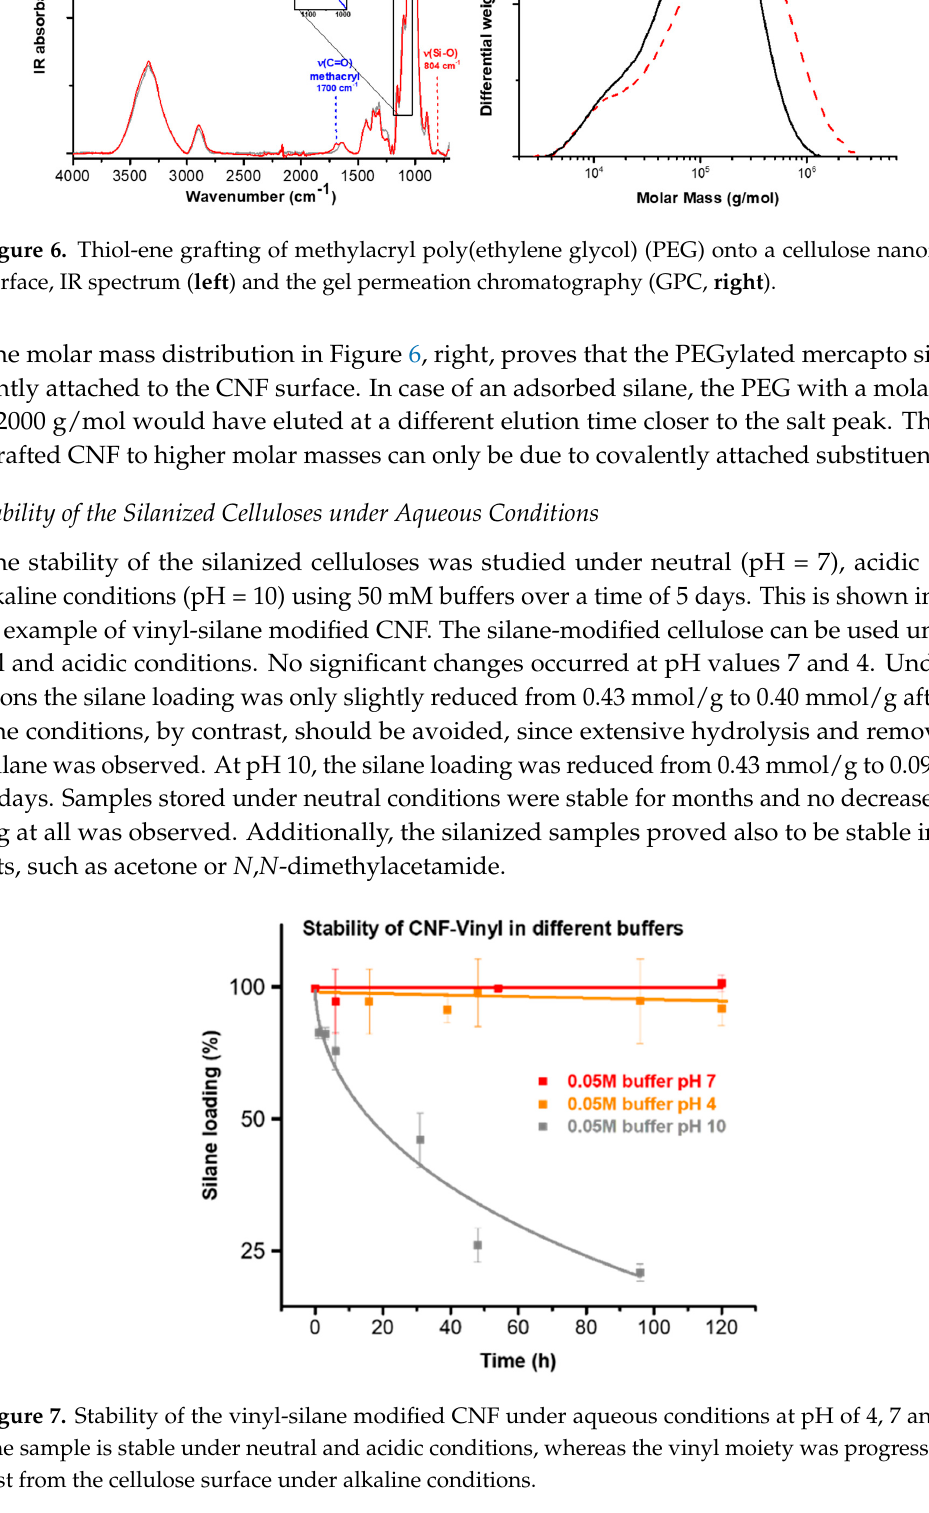
Molecules 2018 , 23 , x FOR PEER REVIEW 8 of 16 Figure 5. ( A ) Comparison of silanization kinetics of cellulose II gel with 3-azidopropyl triethoxysilane between novel approach and conventional literature procedure [6]. The kinetics of the two-step procedure (hydrolysis and condensation) have a linear fit (zero-order) instead of the previous sigmoidal fit. ( B ) Kinetics of the different silanization agents used in this work (substrate cellulose II gel), with the reactivity of the silanes increasing in the order vinyl, azido and mercapto silane. 2.5. Proof of Covalent Modification In our previous publication [6], we already proved that azido-silane reacted covalently under